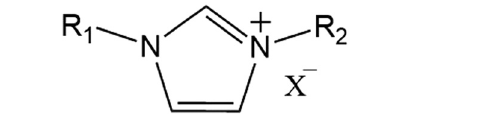
Figure 1: Scheme of three di ff erent imidazolium -